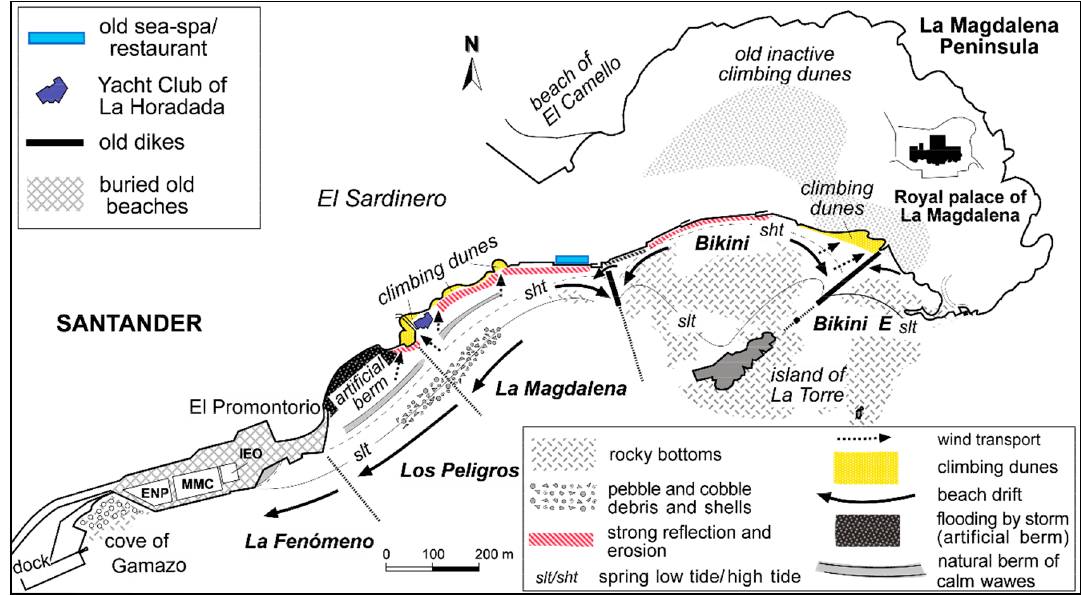
Figure 4. Dynamic-sedimentary processes pre-2018, representing a period of artificial sedimentary transfers between the eastern beaches to La Fenómeno, and from their foreshores to the climbing dunes.